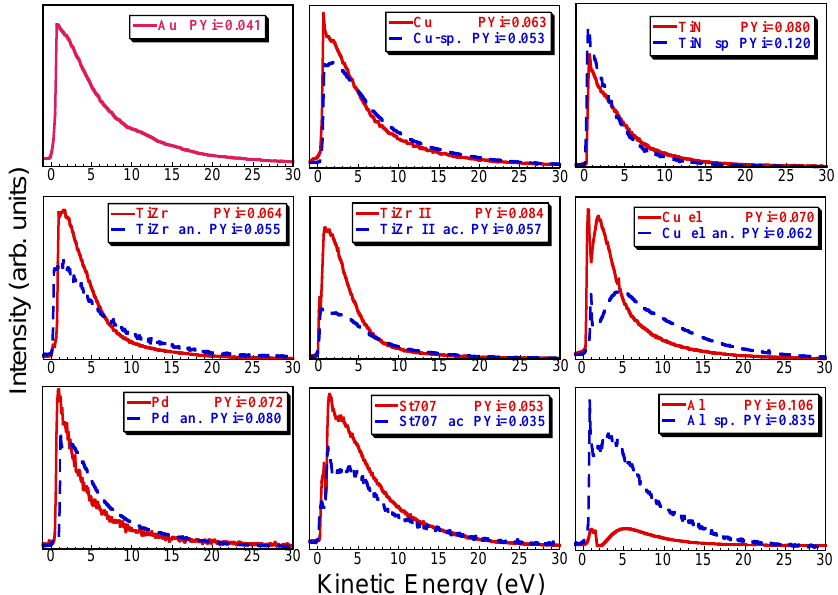
FIG. 16. (Color) The WL excited EDCs. The spectra from as-received (conditioned) samples are depicted with red solid (blue dashed) lines.